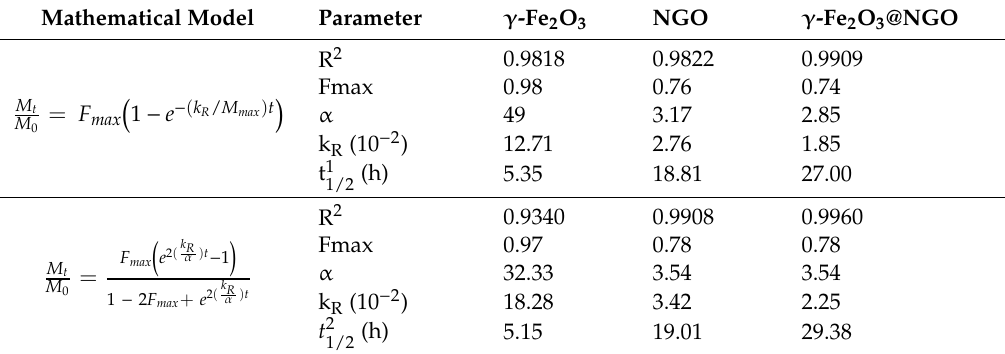
Table 1. R 2 values and kinetic parameters for CisPt release according to the applied mathematical model. Mathematical Model